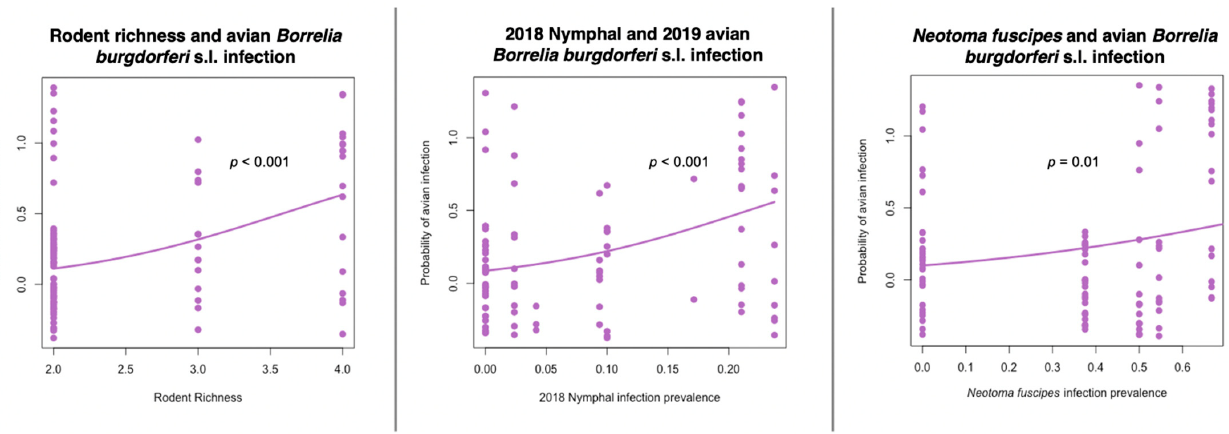
Figure 3. Rodent community composition and tick infection prevalence significantly predicts the probability of avian Borrelia burgdorferi sensu lato infection. Raw data jittered over model predic- tions. Table 3. Binomial model results of natural history and host demographic variables, and host com- munity characteristics as predictors of avian B. burgdorferi s.l. infection status with site as a random variable.